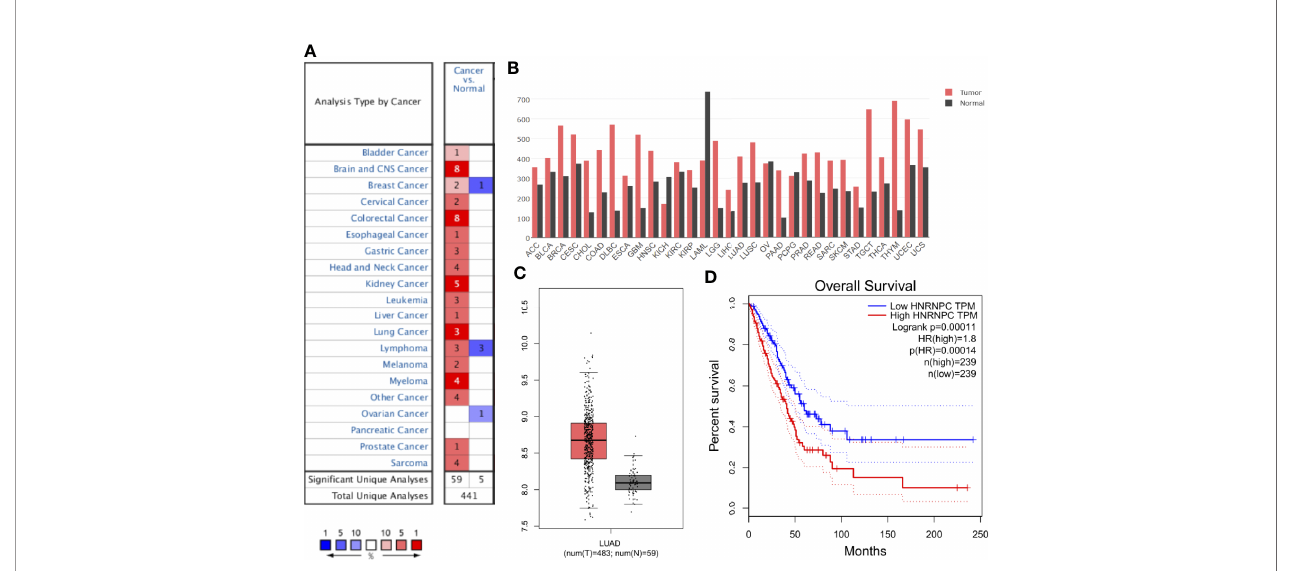
FIGURE 2 | Aberrant up-regulation and prognostic value of HNRNPC in cancer. (A) HNRNPC expression in various cancers based on data from Oncomine. Numbers represent the quantity of datasets with signi fi cantly ( p < 0.001) high (red) or low (blue) HNRNPC expression in different cancers. (B) HNRNPC expression in various cancer and normal tissues by GEPIA. (C) HNRNPC expression in LUAD (red) was higher than that in normal lung tissue (gray) according to GEPIA. (D) GEPIA showed that high HNRNPC levels were signi fi cantly ( p < 0.001) associated with poor overall survival in patients with LUAD. GEPIA, gene expression pro fi ling interactive analysis; LUAD, lung adenocarcinoma; HNRNPC, heterogeneous nuclear ribonucleoprotein C; TCGA, The Cancer Genome Atlas.